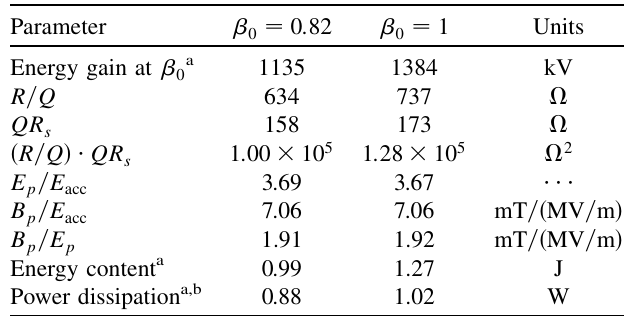
TABLE IV. Radio-frequency properties, 325 MHz, (cid:1) 0 ¼ 0 : 82 and (cid:1) 0 ¼ 1 .